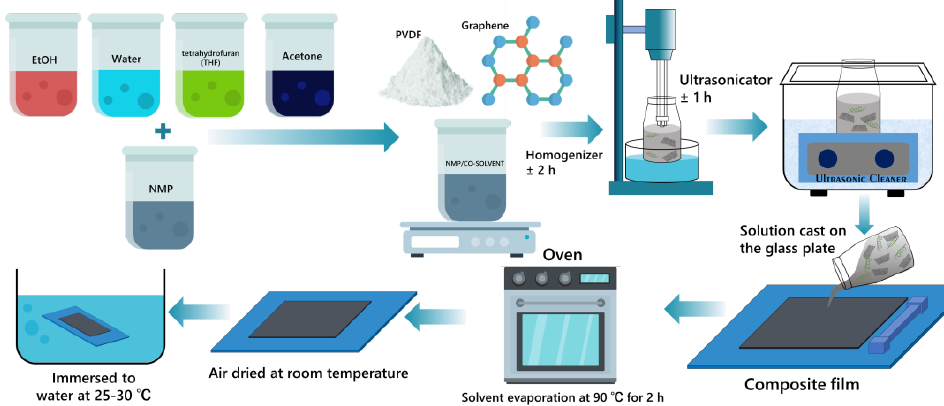
Figure 1. Schematic preparation of graphene–PVDF piezoelectric nanogenerator composite film with different co – solvents.